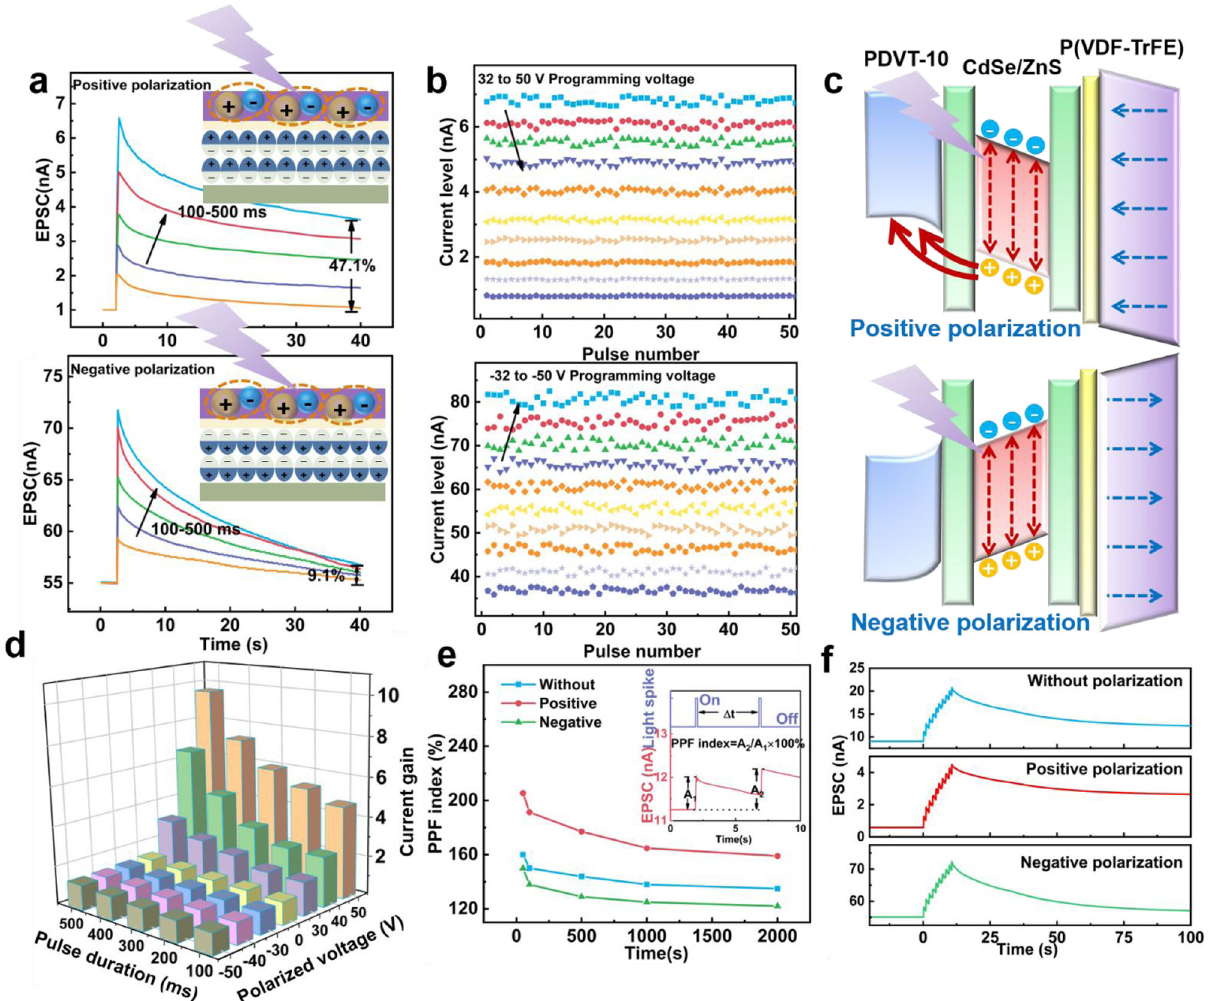
Fig. 3 | Selective attention under polarization. a The exciting postsynaptic cur- rent triggered by variant pulse durations (100, 200, 300, 400, and 500ms) after 40V polarization and – 40V polarization, where the ferroelectric materials ’ coer- cive fi eld can be exploited as photoelectric performance under UV light. b The retention current in the 10 states of EPSCs after positive polarization and negative polarization, where the device is polarized 50 times. c The transferring process of